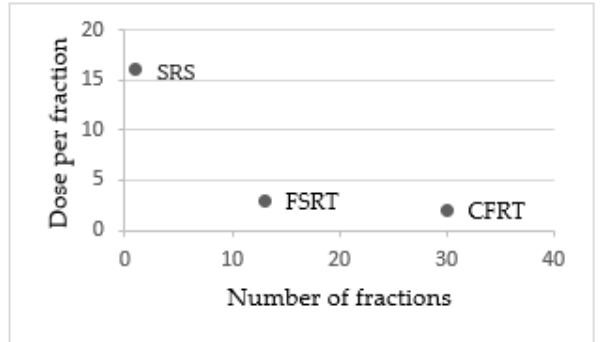
Figure 1. Differences in terms of fractionations between stereotactic radiosurgery (SRS), fractionated stereotactic radiotherapy (FSRT) and conventionally fractionated radiotherapy (CFRT).